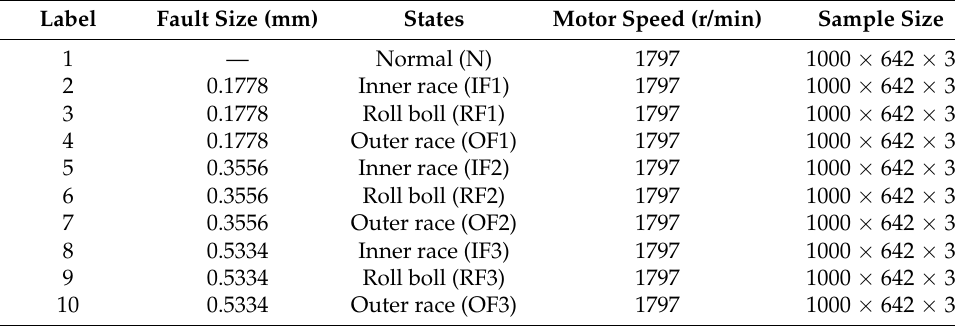
Table 1. Dataset A: CWRU bearing operation states.